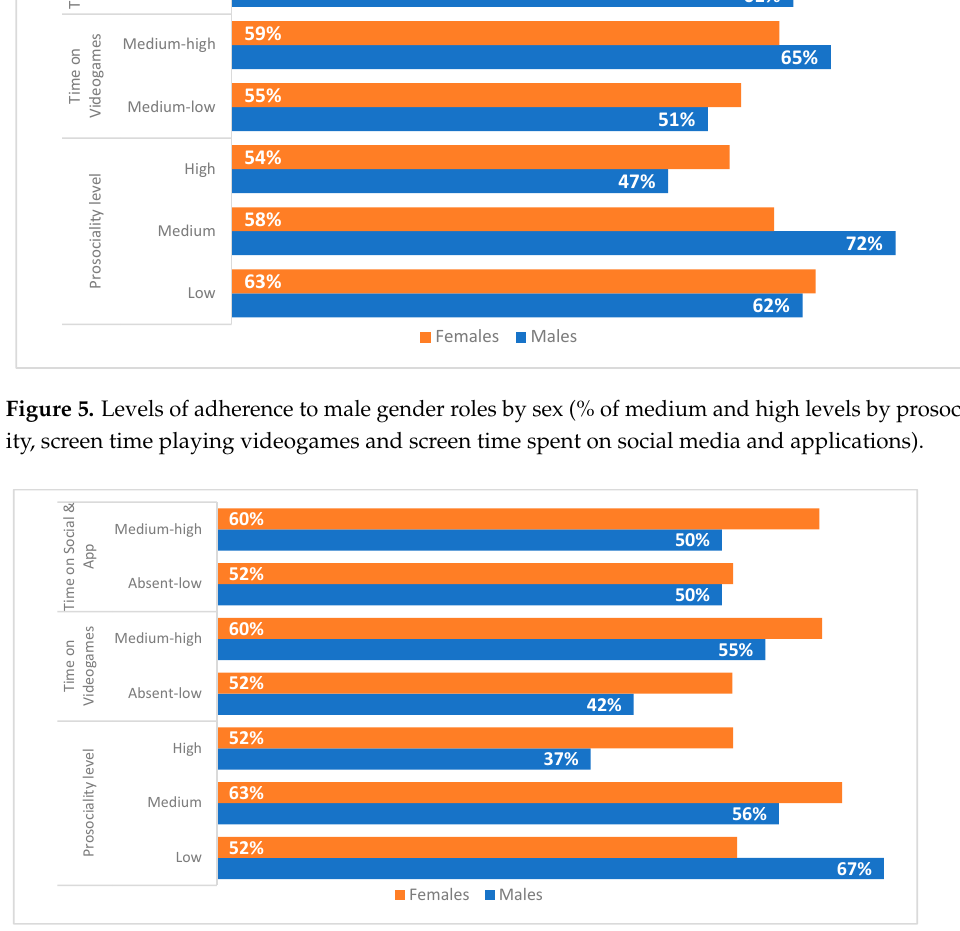
Figure 6. Levels of adherence to female gender roles by sex (% of medium and high levels by prosociality, screen time playing videogames and screen time spent on social media and applications). As the results show, the internalisation to males and females gender roles is higher for both boys and girls as the time they spent playing videogames increased. On the other hand, there are no differences in relation to the time spent on social media and applica- gender roles among girls, it can be claimed that to a high level of prosociality correspond